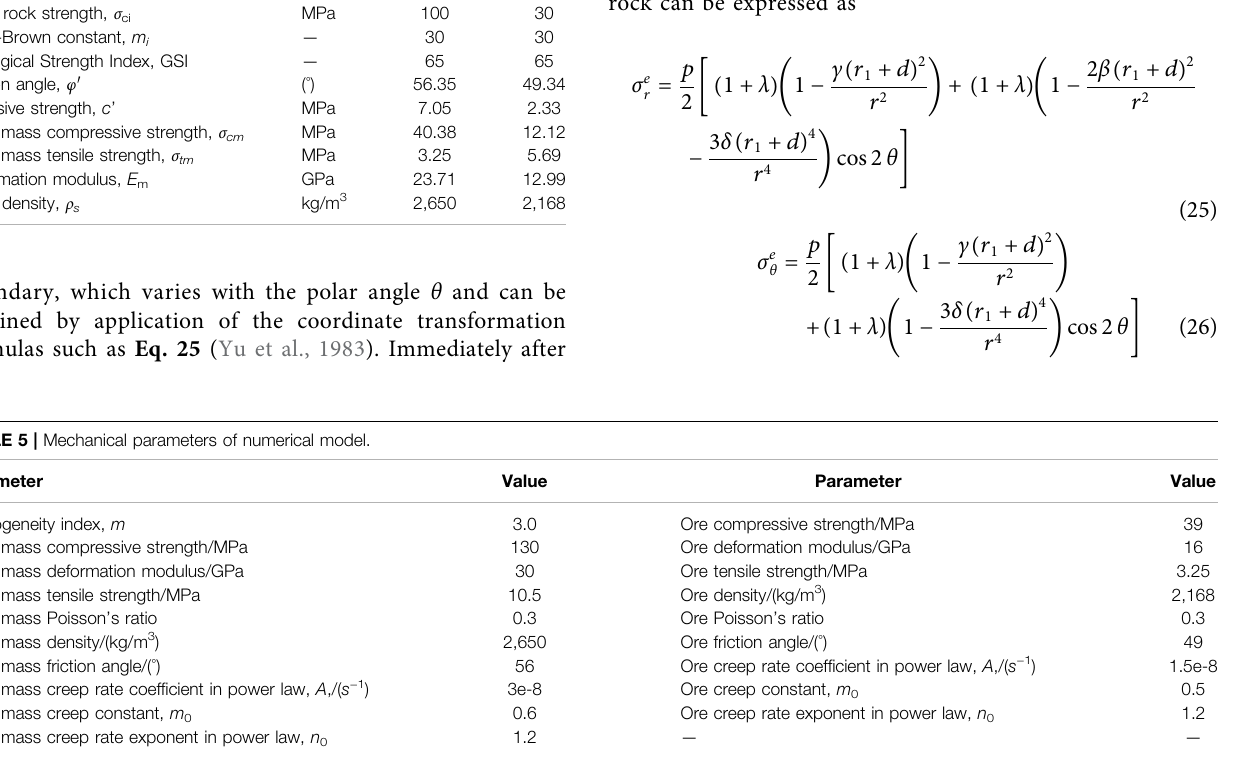
TABLE 4 | Estimated physico-mechanical parameters of rock mass. Parameter